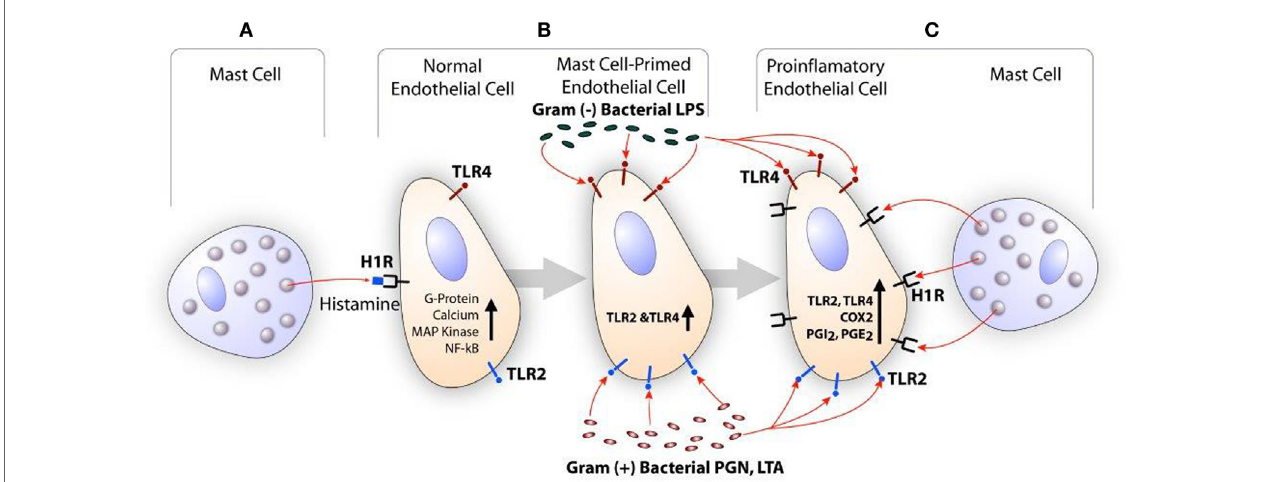
FiGURe 2 | Scheme showing the synergistic activation of inflammatory response in endothelial cells by mast cell-derived histamine and bacterial products . (A) Histamine secreted by the mast cell stimulates H1R on endothelial cells. (B) H1R-mediated endothelial cell activation leads to increased expression of TLR2 and TLR4, and become hyperresponsive to the TLR ligands leading to enhanced inflammatory response. (C) Increased TLR2 and TLR4 signaling increases H1R expression. Finally, collective actions of newly expressed TLR2/TLR4 and H1R lead to increased COX2 expression and other proinflammatory changes in the endothelium resulting in persistent vascular